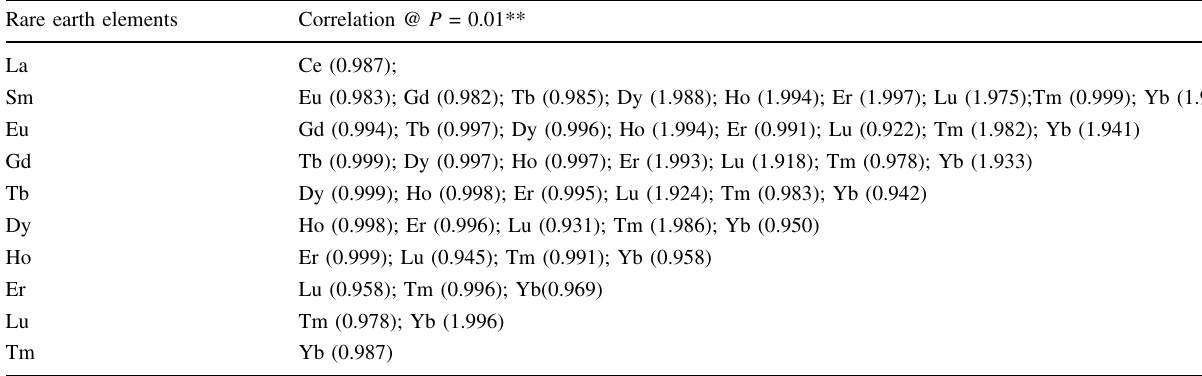
Table 7 Correlation matrix of rare earth elements in coal Rare earth